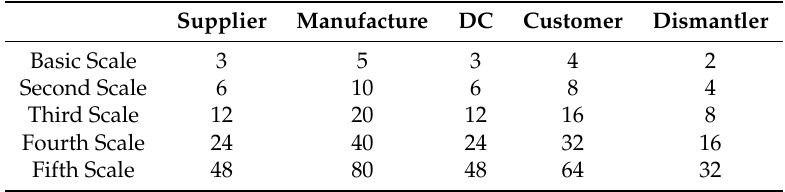
Table 2. Scale of computational experiments. Supplier